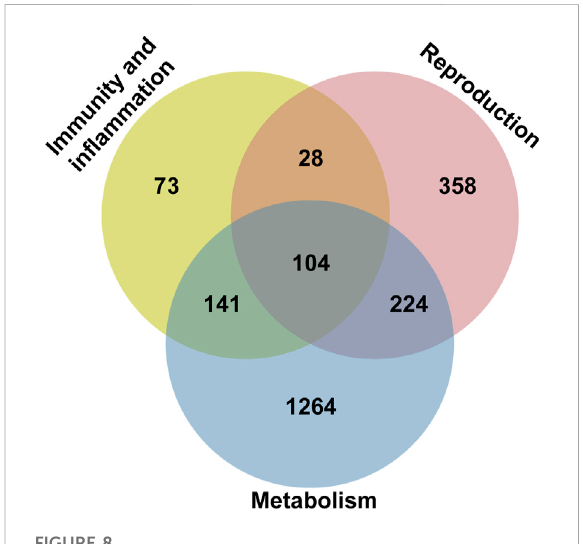
FIGURE 8 Functional classi fi cation of differentially regulated genes from the RNAseq data of cnt1 FD and w 1118 in a Venn diagram. The pie chart shows the distribution of genes in different categories withspecialemphasisonthereproductiondomain.TheVenn diagram shows genes with adj. p -value ≥